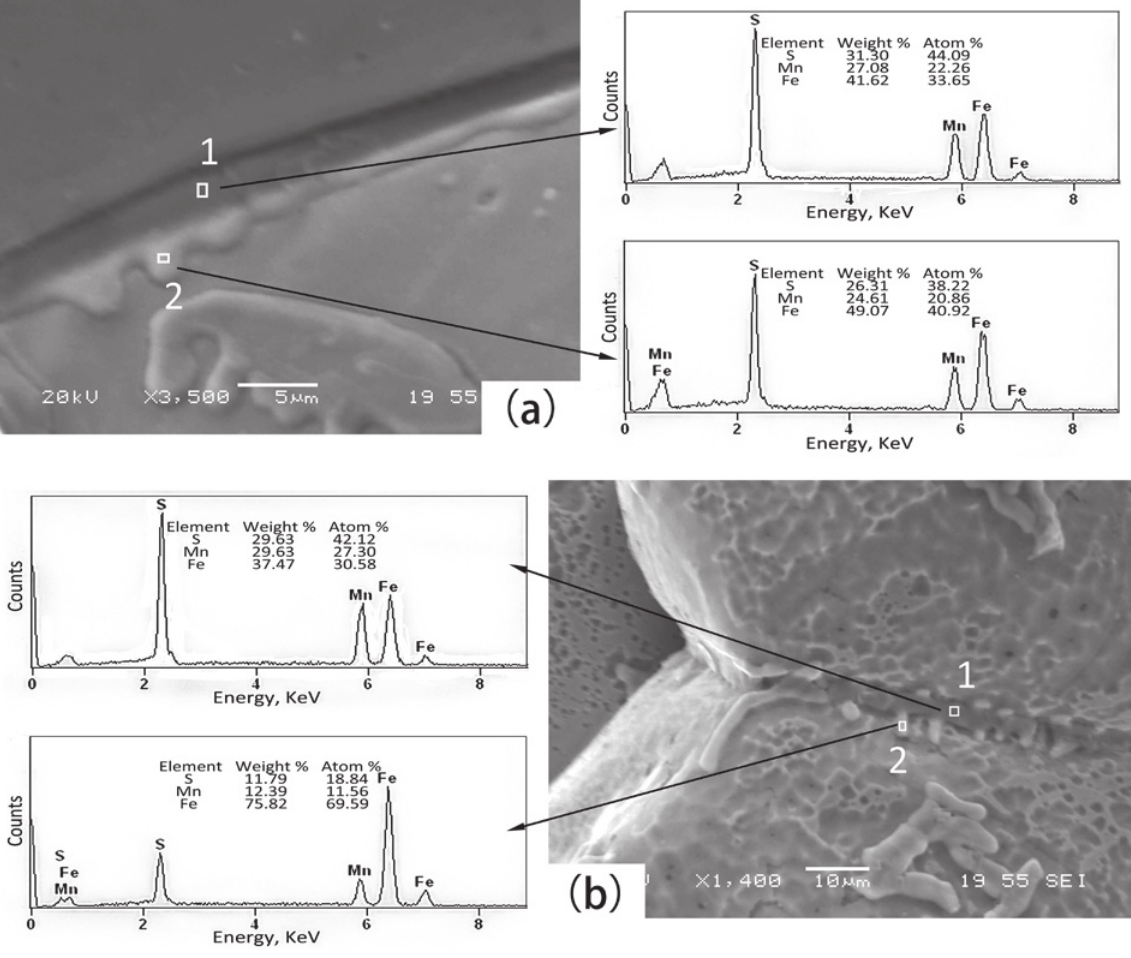
Fig. 7: SEM morphology and EDS analysis of the typical sulfide inclusions formed in sequence for steel 1: (a) 1000 °C; (b) 900